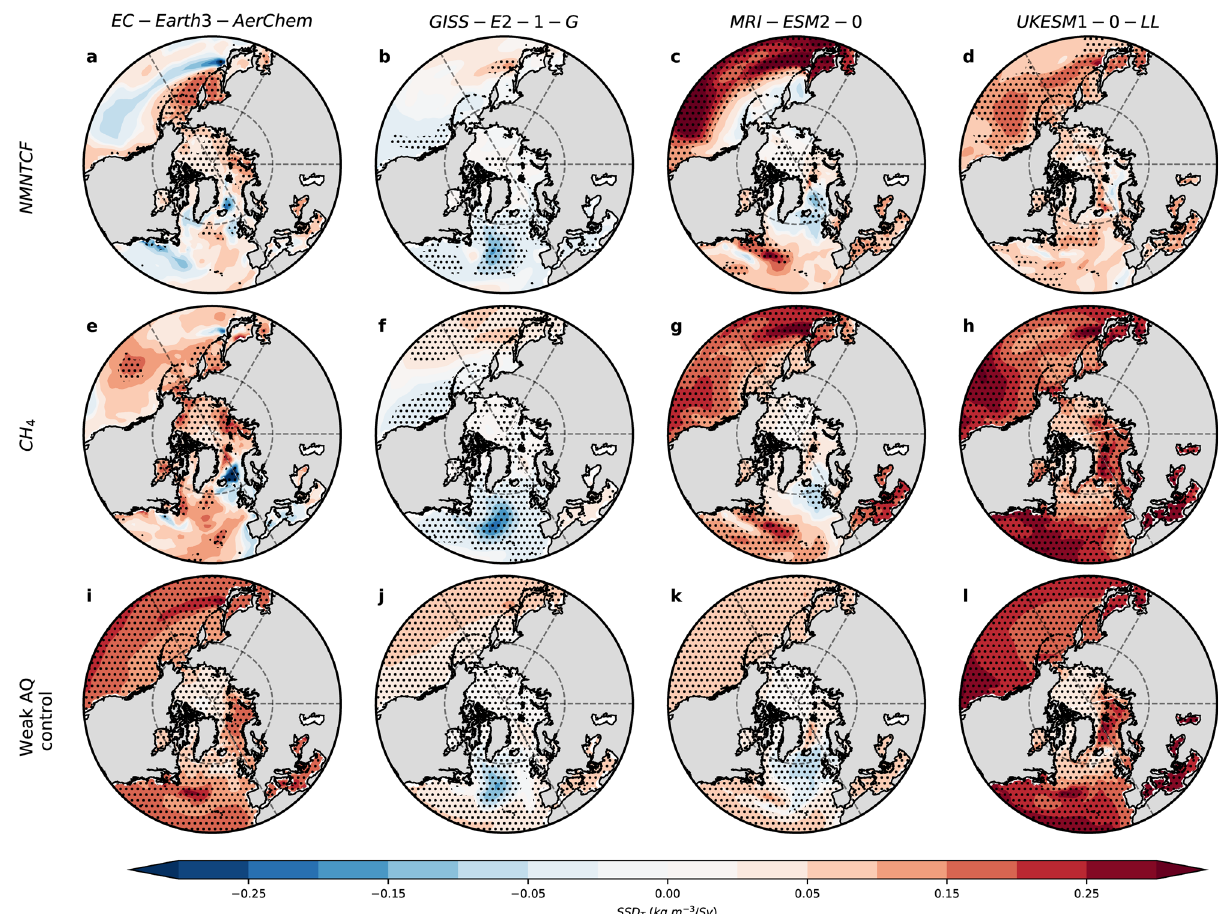
Fig. 5 2015 – 2100 annual mean thermal component of sea surface density (SSD T ) regression analysis. Spatial maps of the AMOC time series regressed onto SSD T under a – d NMNTCF mitigation; e – h CH 4 mitigation; and i – l the weak air quality (AQ) control experiment for a , e , i EC-Earth3-AerChem; b , f , j GISS-E2-1-G; c , g , k MRI-ESM2-0; and d , h , l UKESM1-0-LL. Units are kg m − 3 per Sv. Symbols denote signi fi cance at the 95% con fi dence level based on a standard t